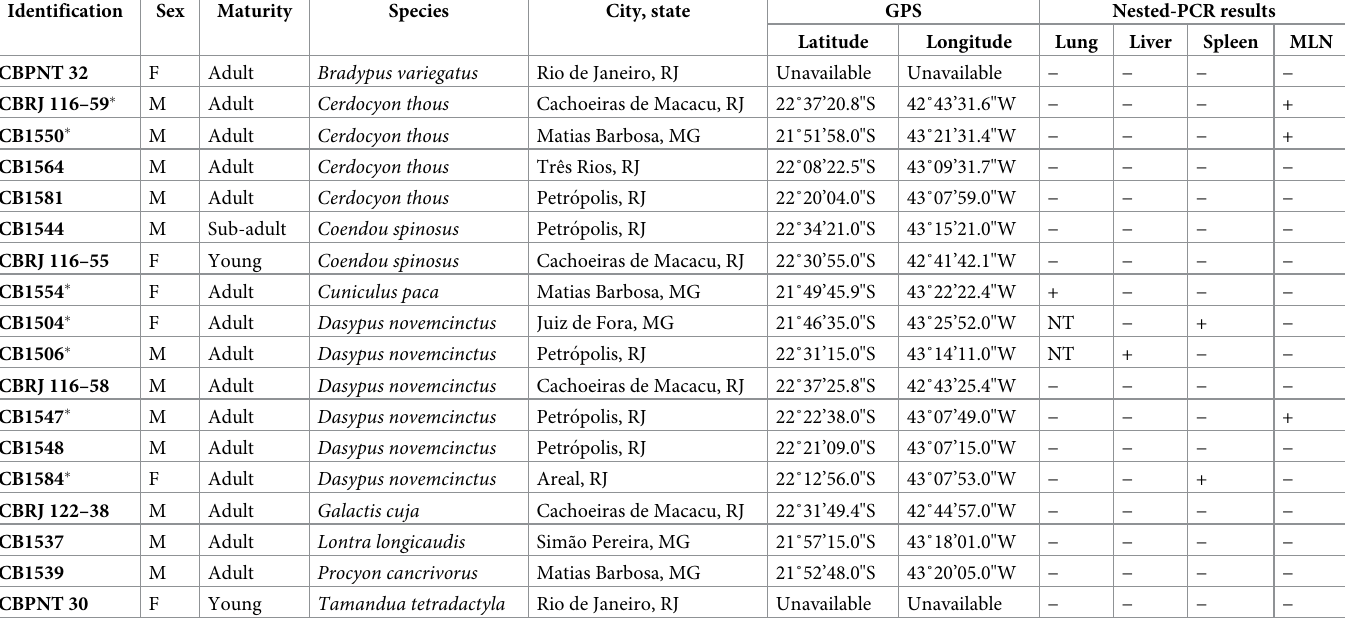
Table 1. Data of the road-killed animals analyzed in this study including their sex, maturity, species, locality and global positions where they were collected, and nested-PCR results from samples of different organs. Identification